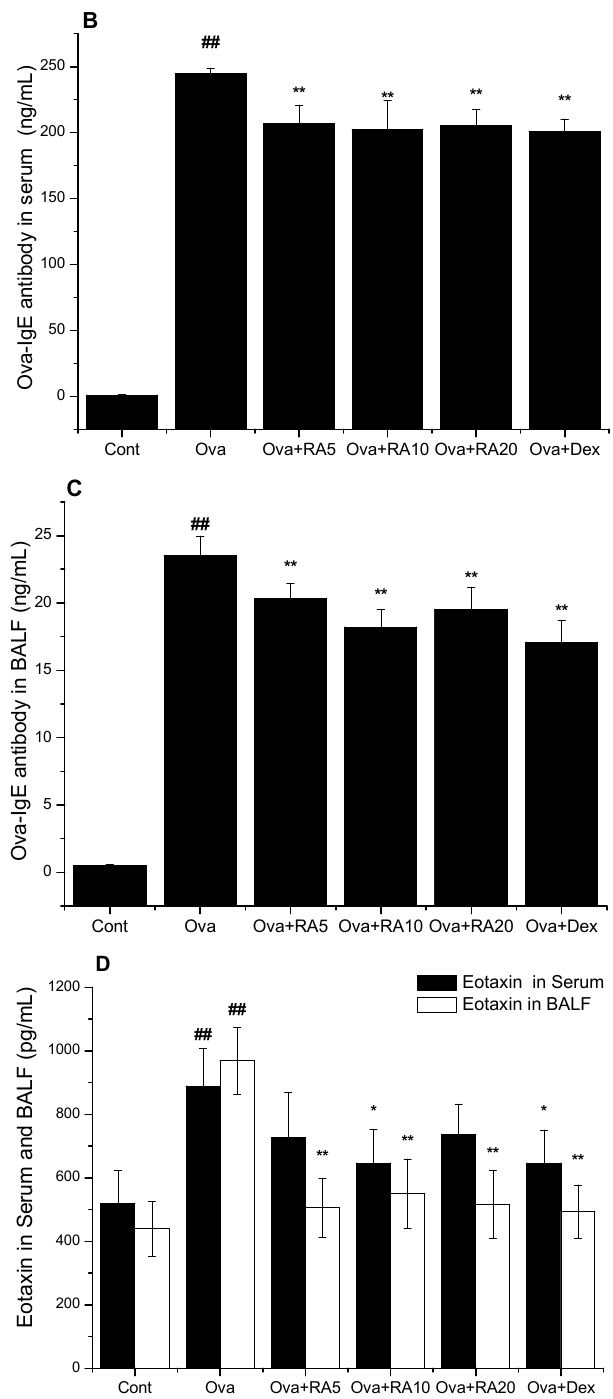
Figure 2. Effects of RA on the secretion of total IgE in the serum ( A ); Ova-specific IgE in the serum ( B ); Ova-specific IgE in the BALF ( C ) and eotaxin in the serum and BALF ( D ). The serum and BALF were analysed by ELISA. The values represent the mean ± SEM of three independent experiments. # p < 0.05, ## p < 0.01 vs. control group; and * p < 0.05, ** p < 0.01 vs. Ova.